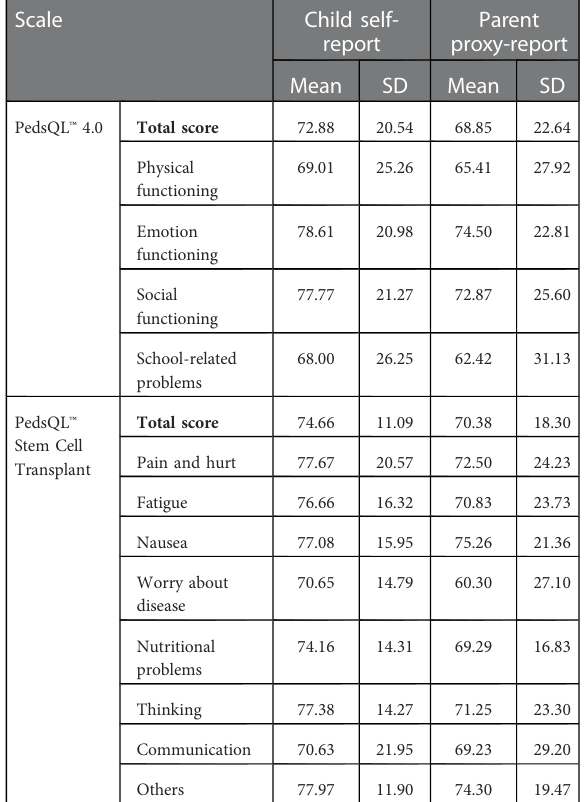
TABLE 3 The PedsQL ™ 4.0 generic core scales and stem cell transplant module scores.